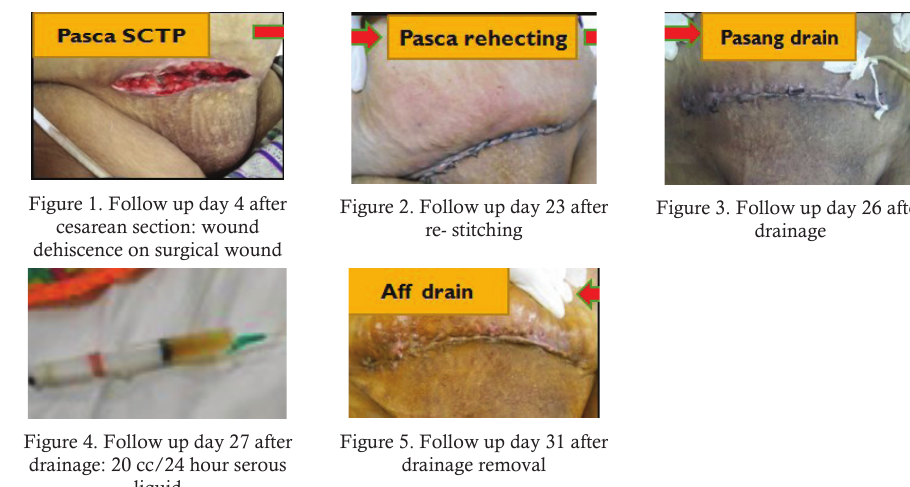
Figure 4. Follow up day 27 after drainage: 20 cc/24 hour serous liquid